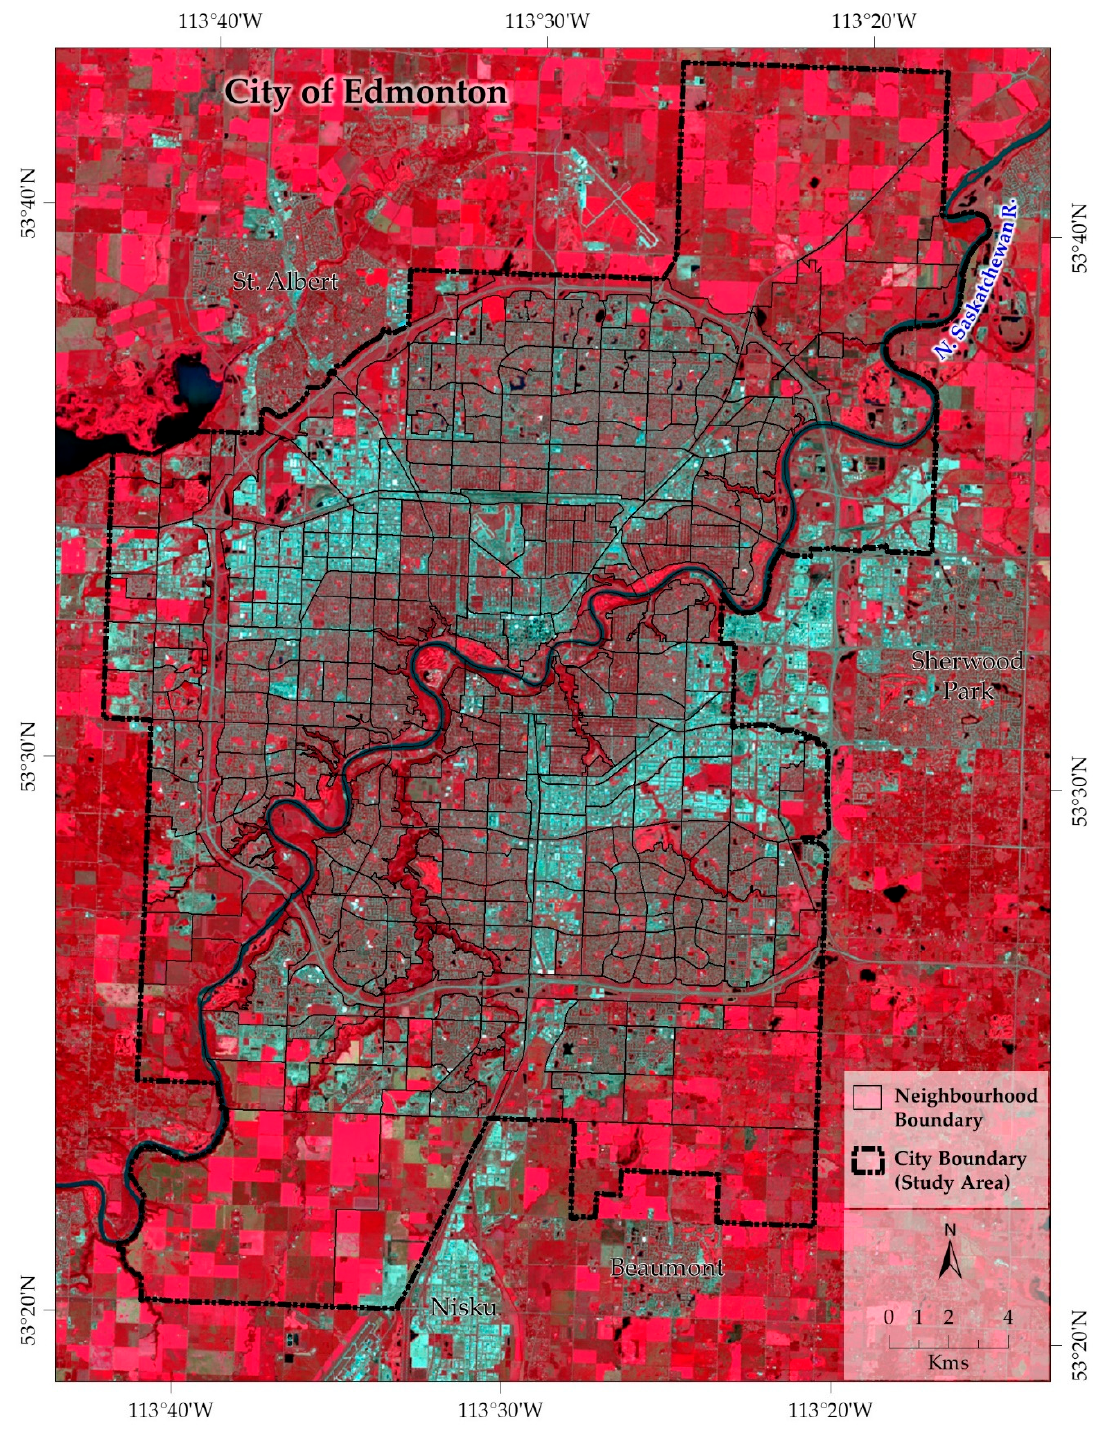
Figure 1. Study area showing the City of Edmonton’s extent in the Canadian Province of Alberta, where the city comprises o00 neighbourhoods. The boundaries of these neighbourhoods were overlaid on a Landsat-8 OLI (operational land imager) image with a false colour composite (RGB:543) acquired on 07 September